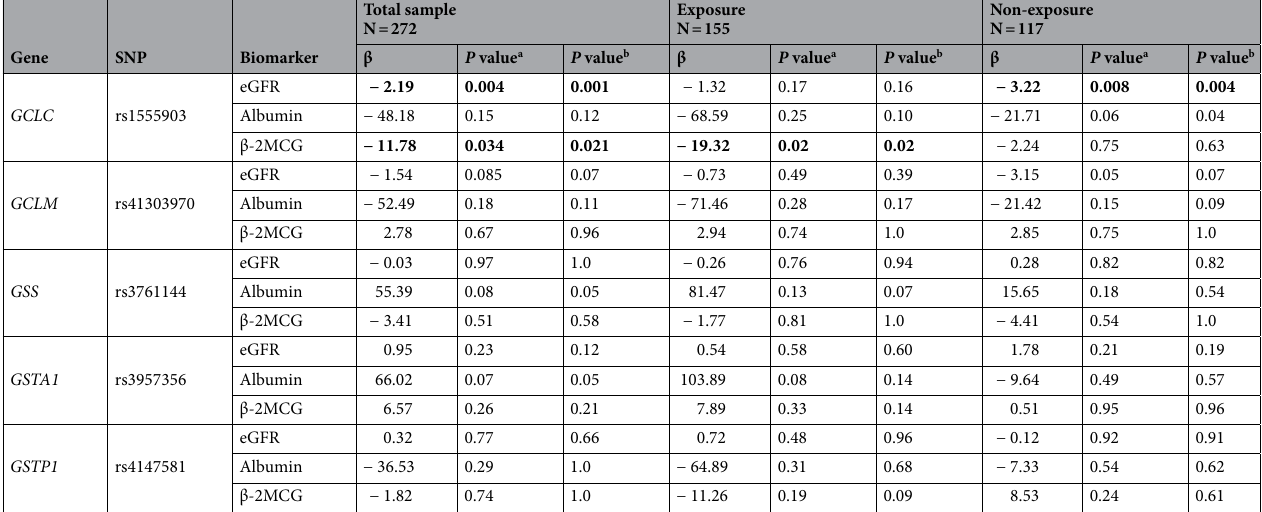
Table 4. Association of genetic variants in glutathione-related genes with kidney function biomarkers. Statistically significant association are shown in bold (P value < 0.05). Each SNP was examined using multivariable linear regression models assuming additive model of inheritance adjusted by age, sex, blood-Hg levels (µg Hg/L), urine-Hg levels (µg Hg/g creatinine), hair-Hg levels (µg Hg/g hair), and duration of exposure (years). Having lower eGFR levels, higher albumin levels or higher β-2MCG levels are indicative of kidney injury. a P value from a generalized linear model. b Empirical P value determined based on 5000 permutations from a generalized linear